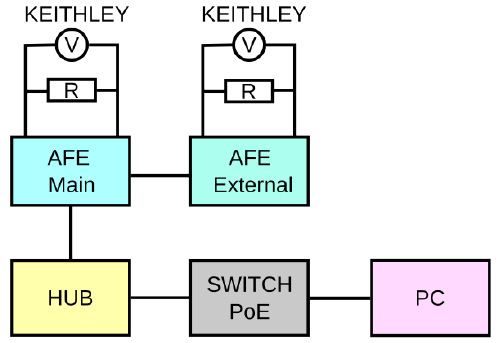
Figure 11. Schematic diagram of the measuring station for calibration measurements (visualisation shown in Figure 10,